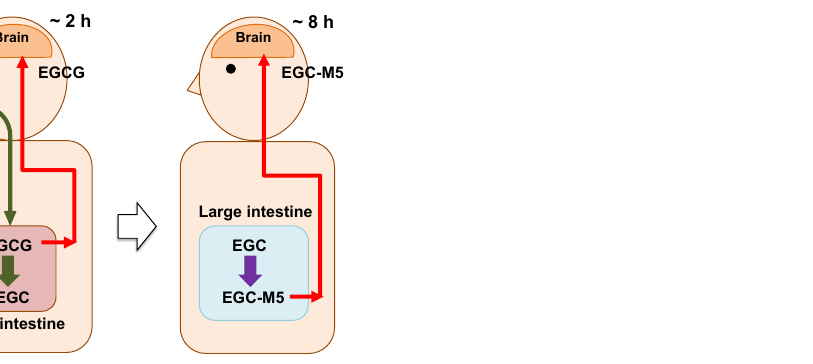
Figure 4. The hypothesis that EGCG and its degradation products act on the brain with a time lag.